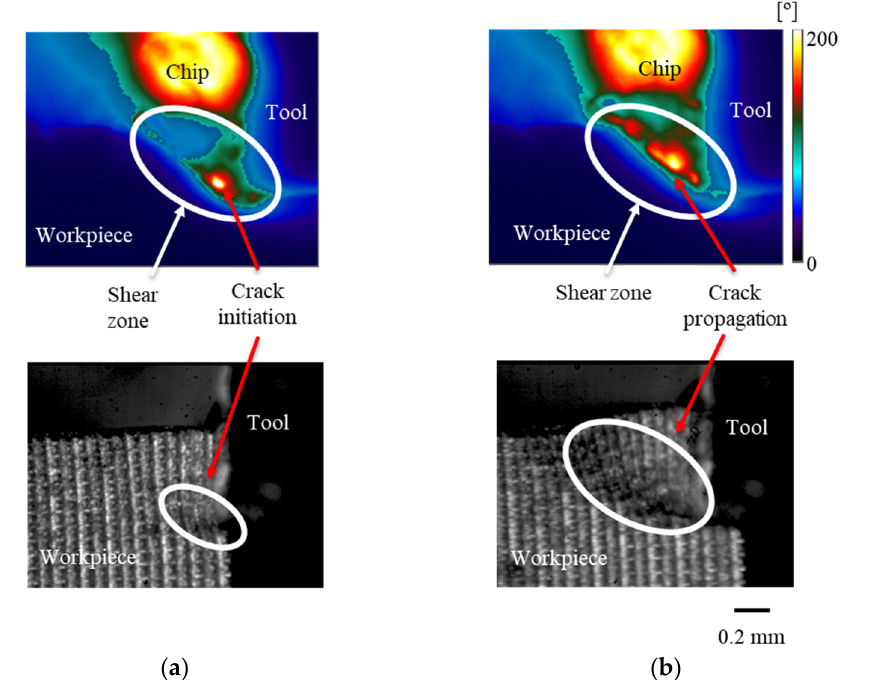
Figure 5. Thermal fields and high ‐ speed images during orthogonal cutting of Ti6Al4V. ( a ) Crack initiation. ( b ) Crack propagation. V c = 7.5 m/min and f = 0.4 mm.